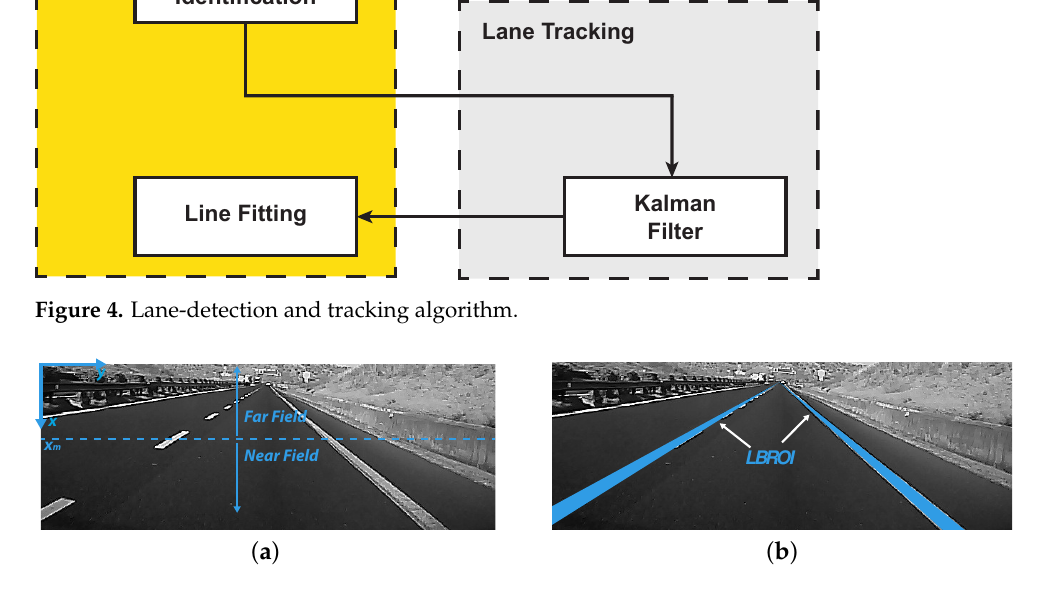
Figure 5. Linear–parabolic fitting: near and far field image separation ( a ) and LBROI ( b